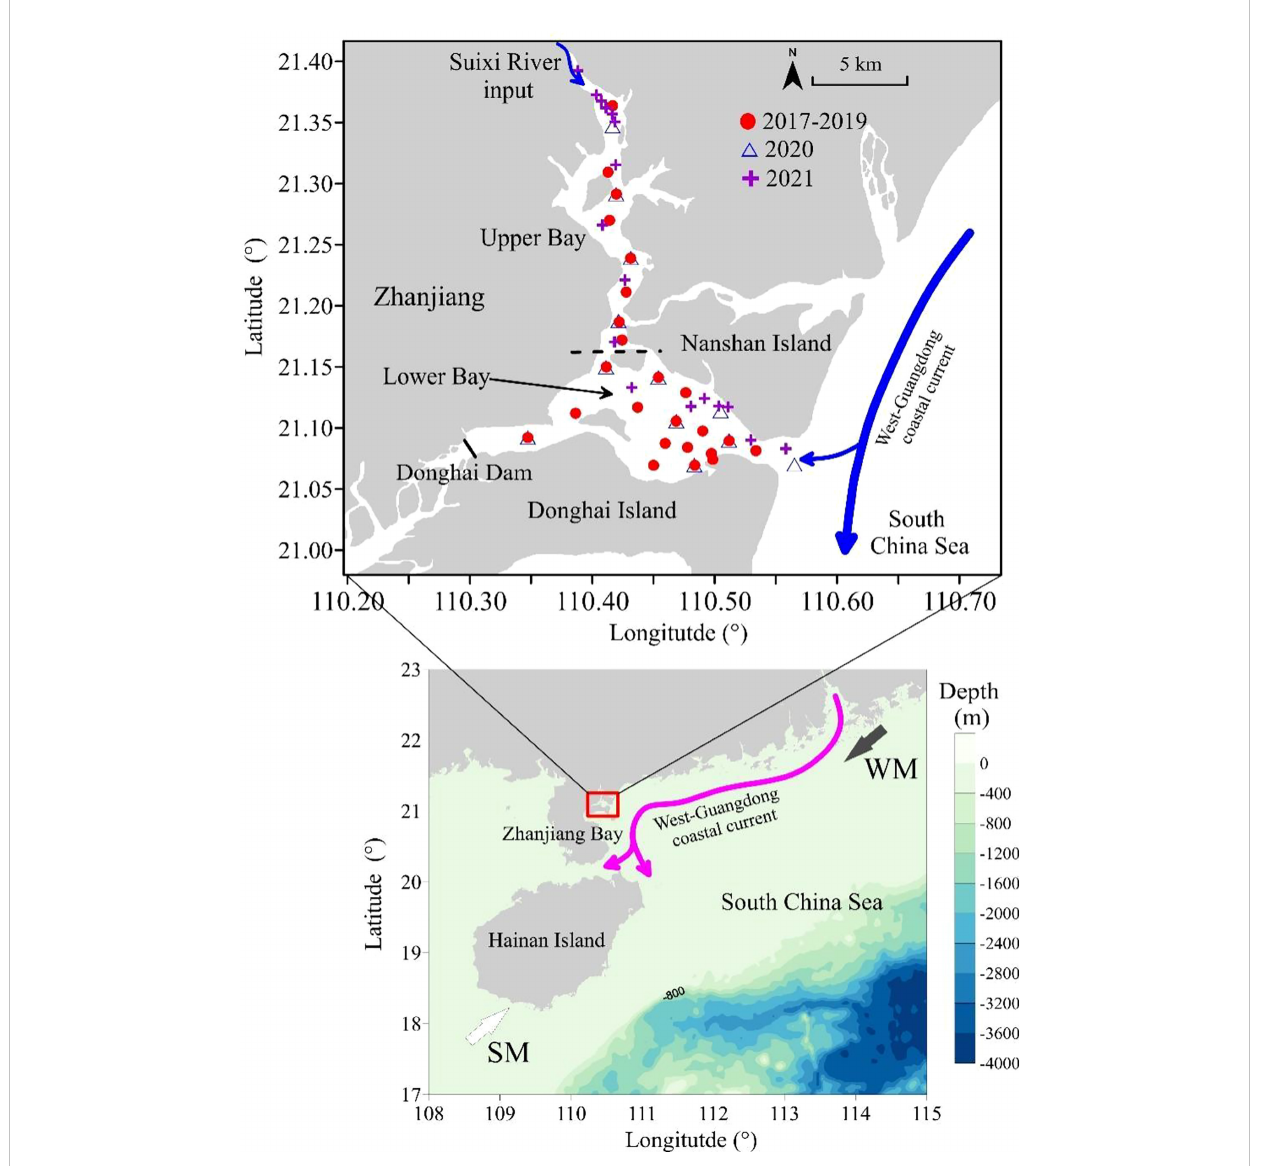
FIGURE 1 Study area and the sampling sites in the Zhanjiang Bay during 2017-2021. The hydrodynamic characteristics of Zhanjiang Bay is modi fi ed from Lao et al., 2022. SM, summer monsoon; WM, winter